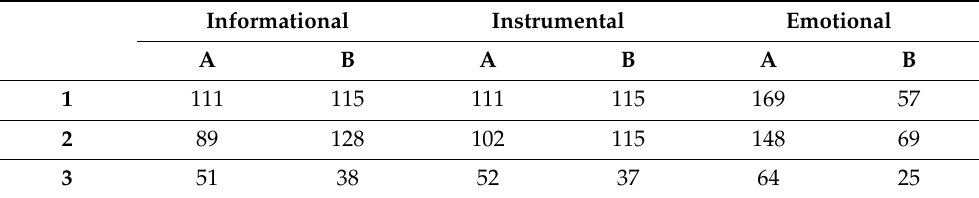
Table 4. Forms of support reported by students (A = domestic students, B = international students) belonging to each of the burnout profiles 1 = Exhausted; 2 = Exhausted and cynical 3 = No exhaustion or